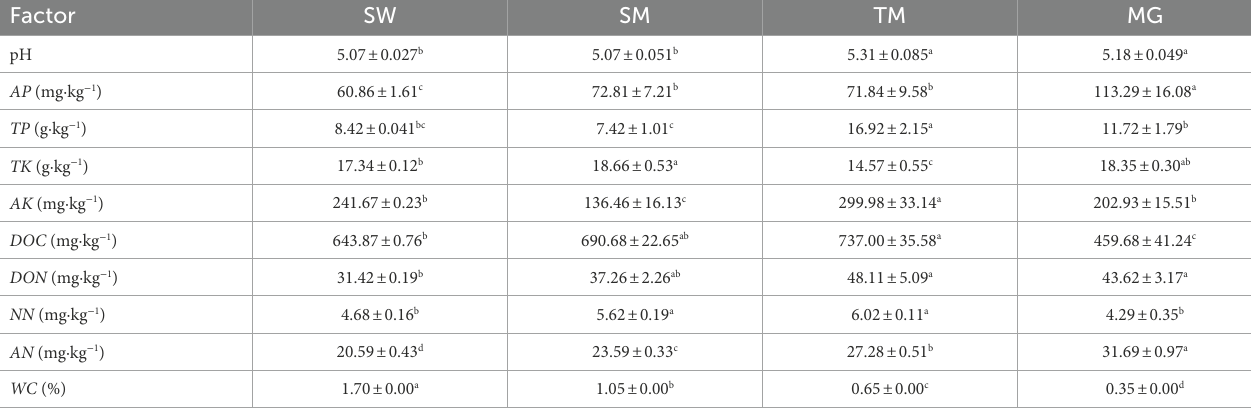
TABLE 1 Characteristics of environmental factors in heterogeneous habitats (mean ± SE).